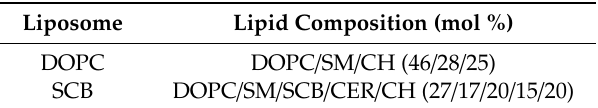
Table 1. Liposome